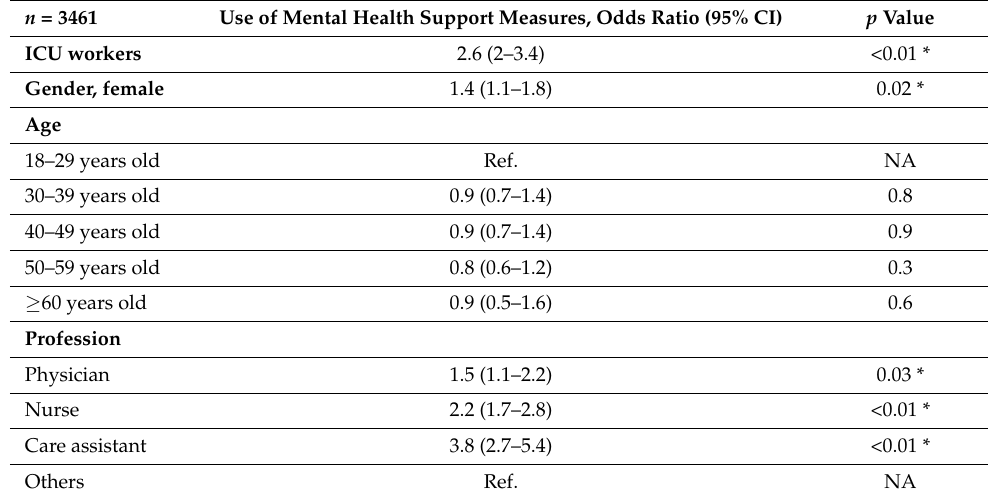
Table 3. Factors associated with the use of mental health support measures provided by the